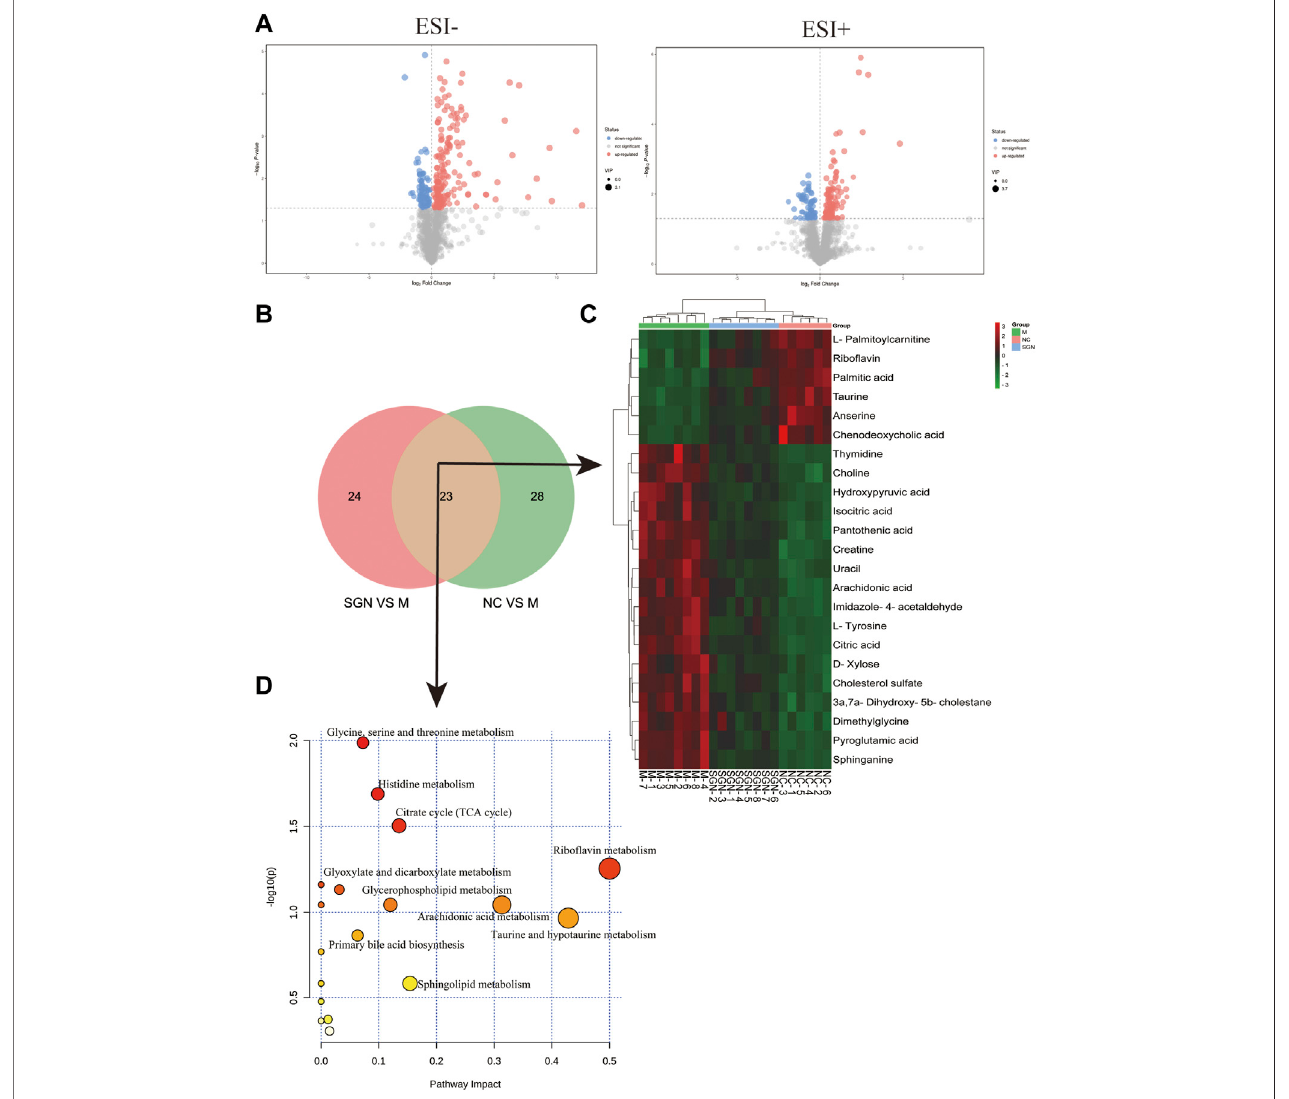
FIGURE 5 | (A) Differential metabolite volcano plot of SGN VS. M in negative and positive ion mode. (B) Venn plot of common metabolites in the SGN and NC groups. (C) Heatmap of different endogenous metabolites. Rows represent the metabolites, and columns represent the corresponding group. (D) Serum metabolism pathway in ethanol-induced GU rats treated with